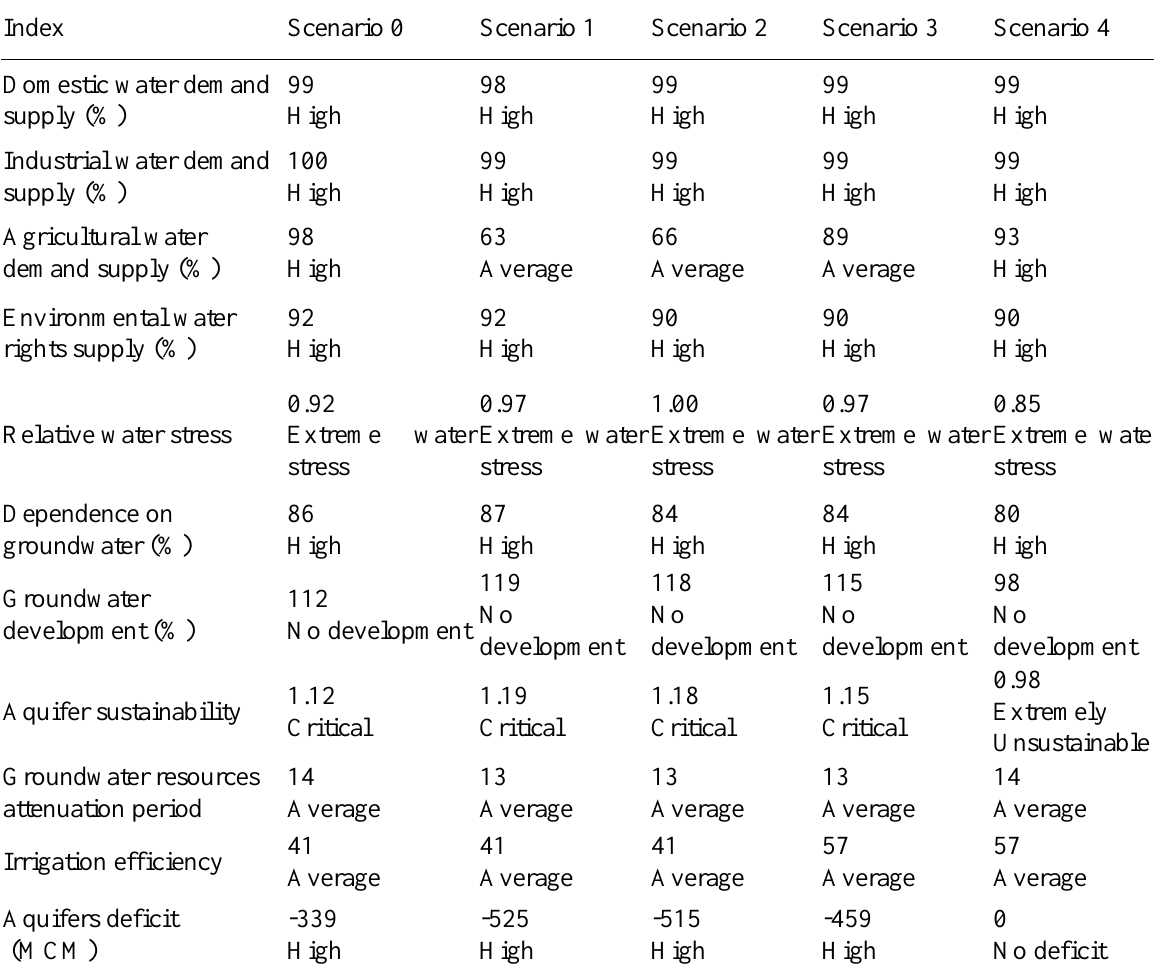
Table 3. Indices quantitative results for evaluating different